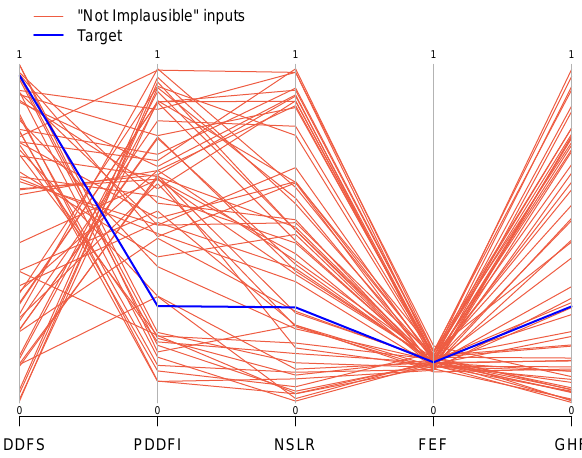
Fig. 5. Parallel coordinates plot of emulated “not implausible” ( I < 3 ) ensemble members (red), when the true inputs are those of the (arbitrarily chosen) first ensemble member (blue). Lines join points on the y-axis, normalised to the ensemble maxima and minima, with each line representing a point in parameter space. Implausibility is calculated as the maximum of all three summaries of the output data – ICEVOL, ICESA and MAXTHK. Emulated implausible members (not shown) are spread evenly through the input space, and would cover the entire range if shown.